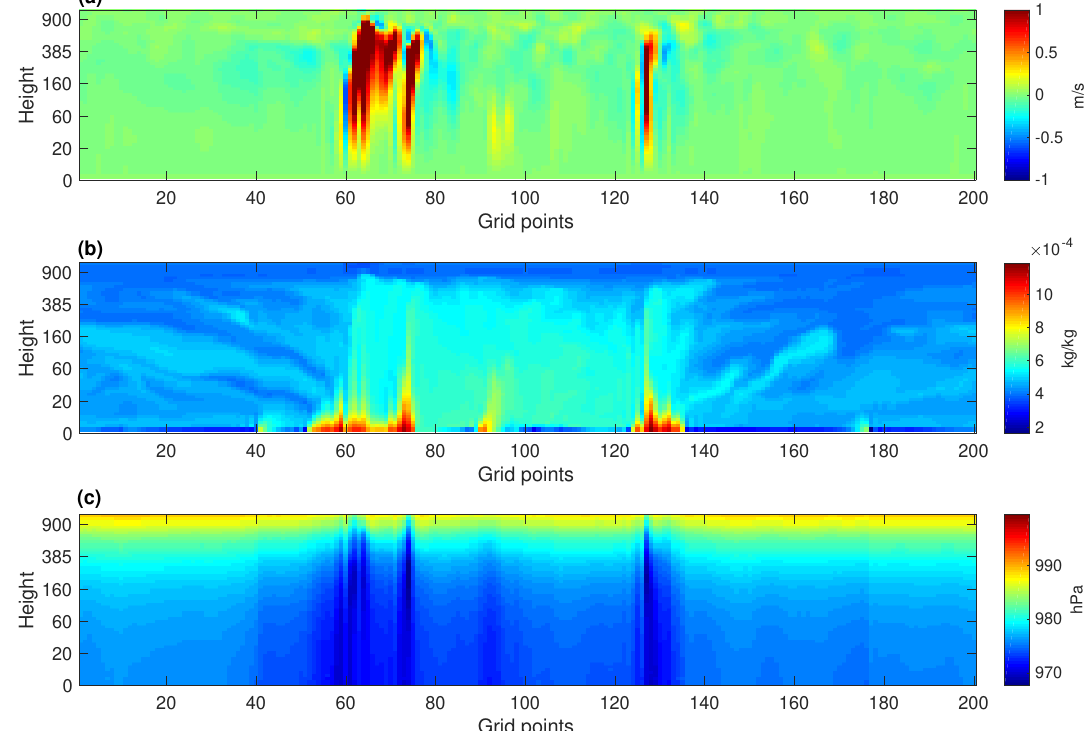
Figure 3. Simulation with weak wind condition (zero initial wind), c = 80% and N f = 100, crosswise transect of: vertical velocity component of the air motion (m/s; a ), water vapor mixing ratio (kg/kg; b ), and atmospheric pressure (hPa; c